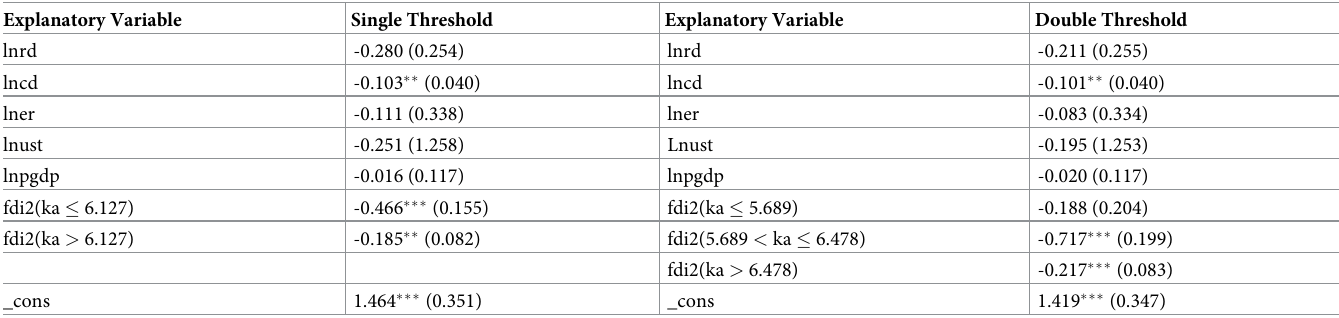
Table 6. FDI quality threshold model estimation